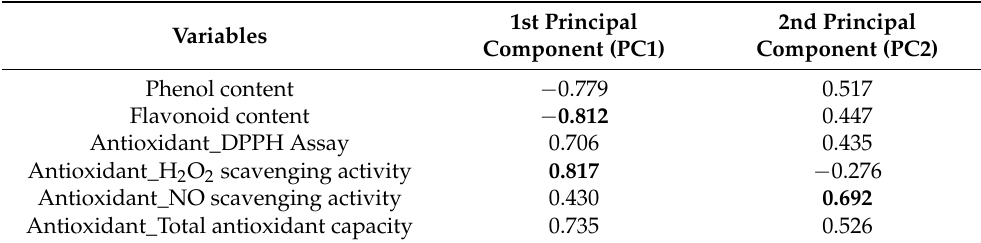
Table 6. Component score coefficient matrix (coefficients by which variables are multiplied to obtain factor scores). The highest score coefficients in absolute value are marked in bold.